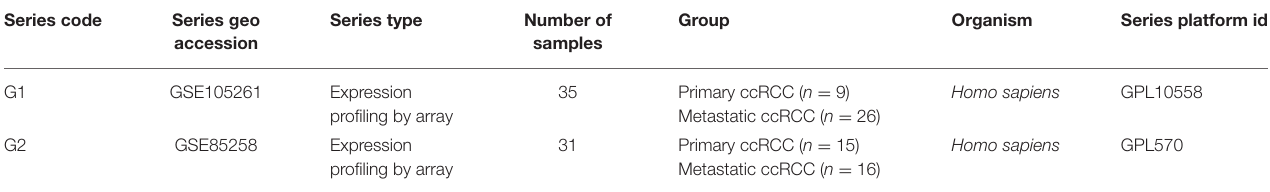
TABLE 1 | Characteristics of the GSE105261 and GSE85258 datasets. Series code